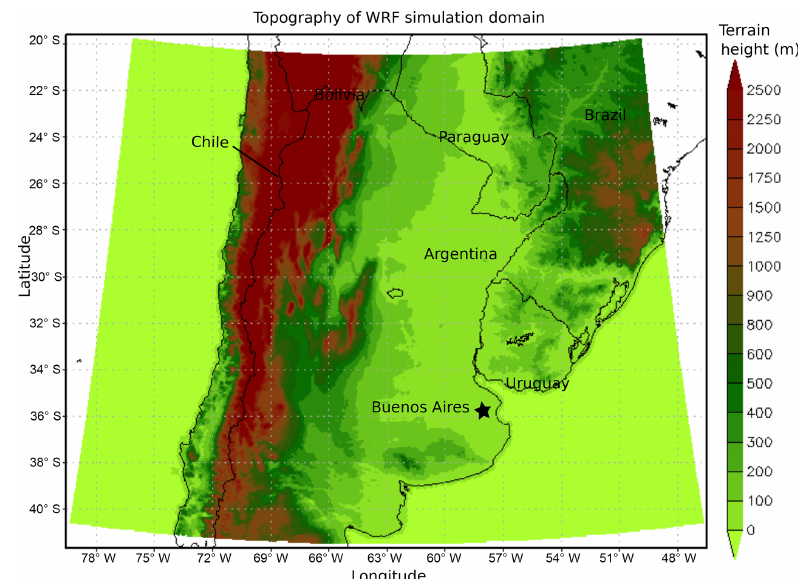
Figure 3. The geographical domain used in WRF model runs illustrated by the topography of the region in